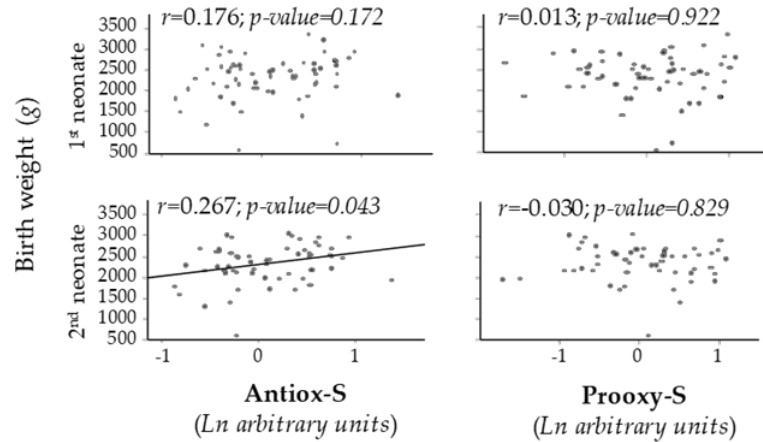
Figure 2. Scatter plots of birth weight vs. maternal Antiox-S or Prooxy-S values. Line shows p < 0.05. Rho–Spearman test.